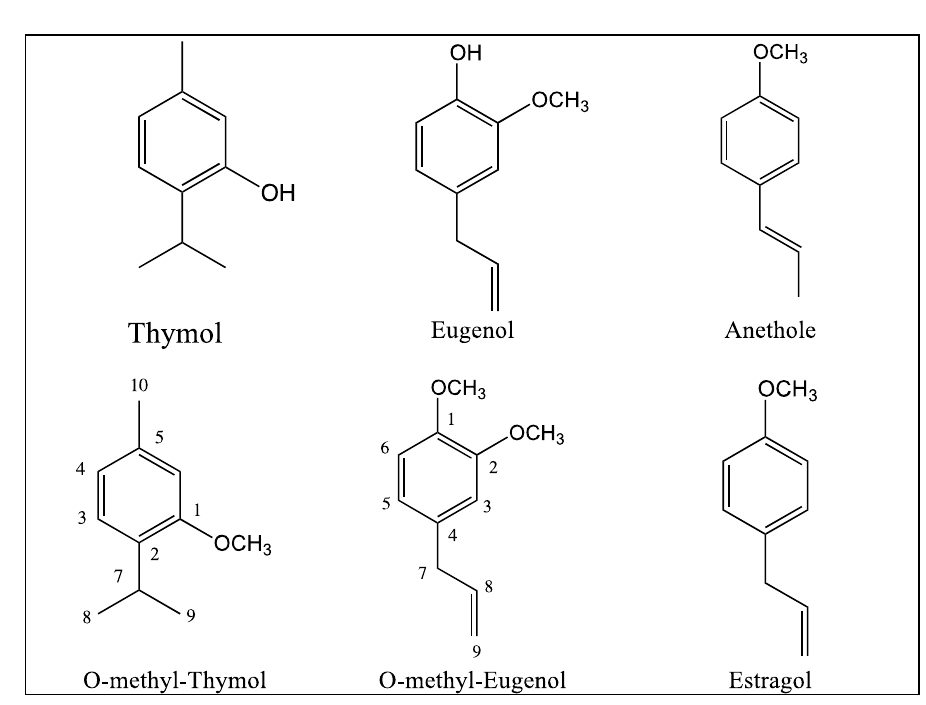
Figure 1. Chemical structures of antifungal